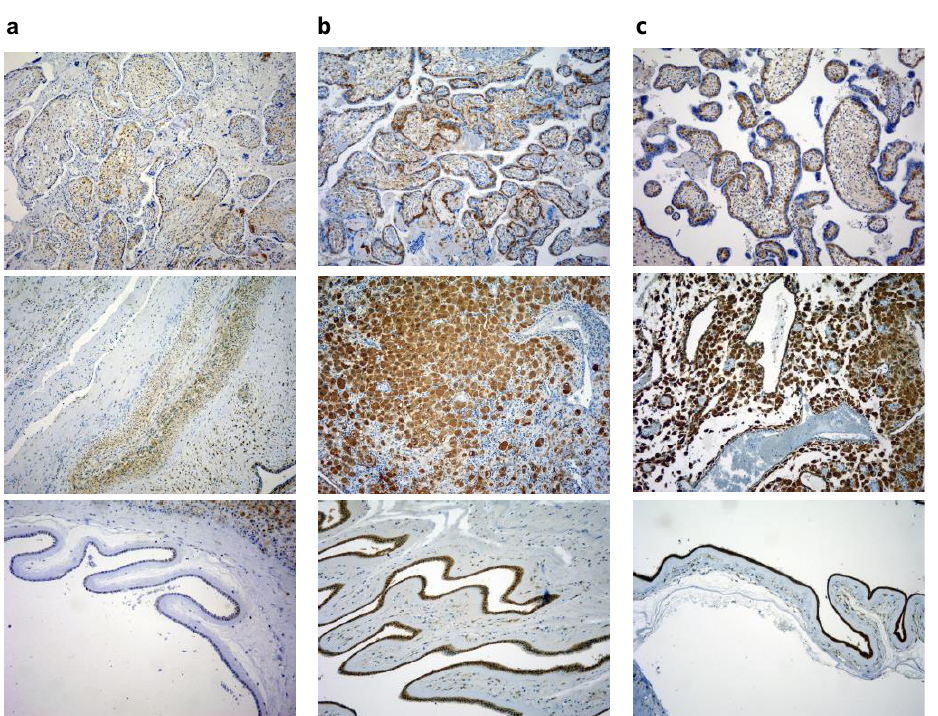
Figure 2. Example of staining intensity scores 1 ( a ), 2 ( b ), and 3 ( c ) for Gal-3 in decidua, villi and fetal membranes tissues (magnification 100×).